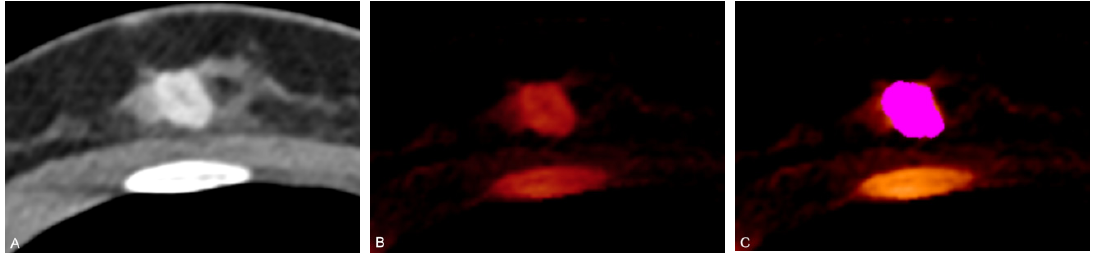
Figure 3. Axial contrast-enhanced dual-energy CT (DECT) scan of a 47-year-old woman with grade 1 luminal A invasive ductal carcinoma in the right breast. Linearly blended M_0.6 series ( A ) demonstrate a contrast-enhancing mass; pure iodine maps ( B ) reconstructed from DECT datasets display iodine content within the lesion. A three-dimensional volume of interest (VOI) ( C ) is placed semi-automatically on the iodine map for radiomic analysis.